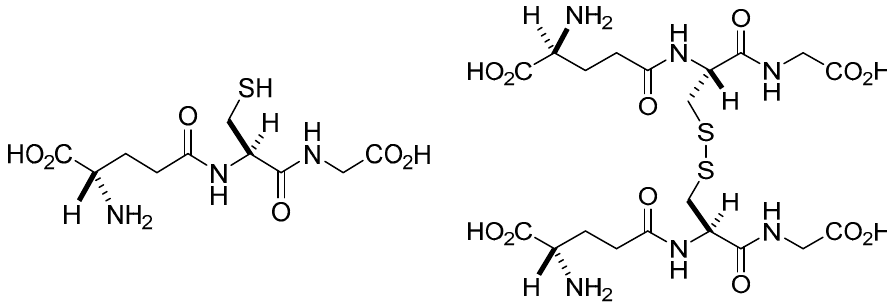
Figure 1. Structure of reduced (GSH) and oxidized (GSSG) forms of glutathione.